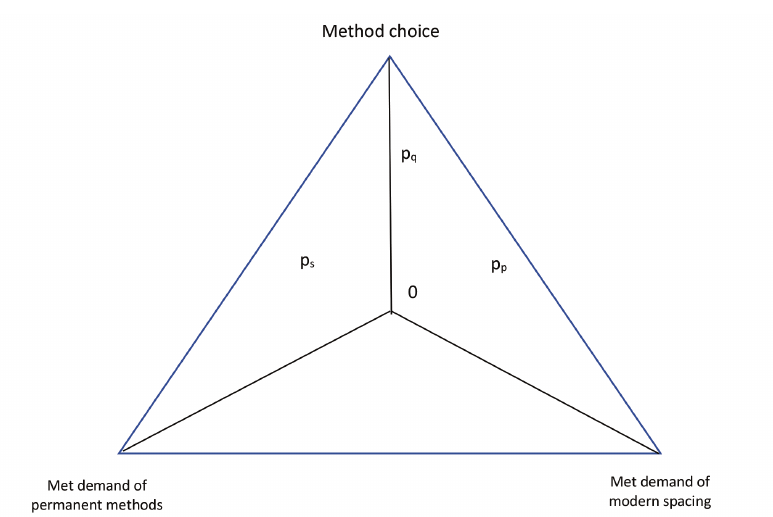
Figure 1: The Family Planning Progress